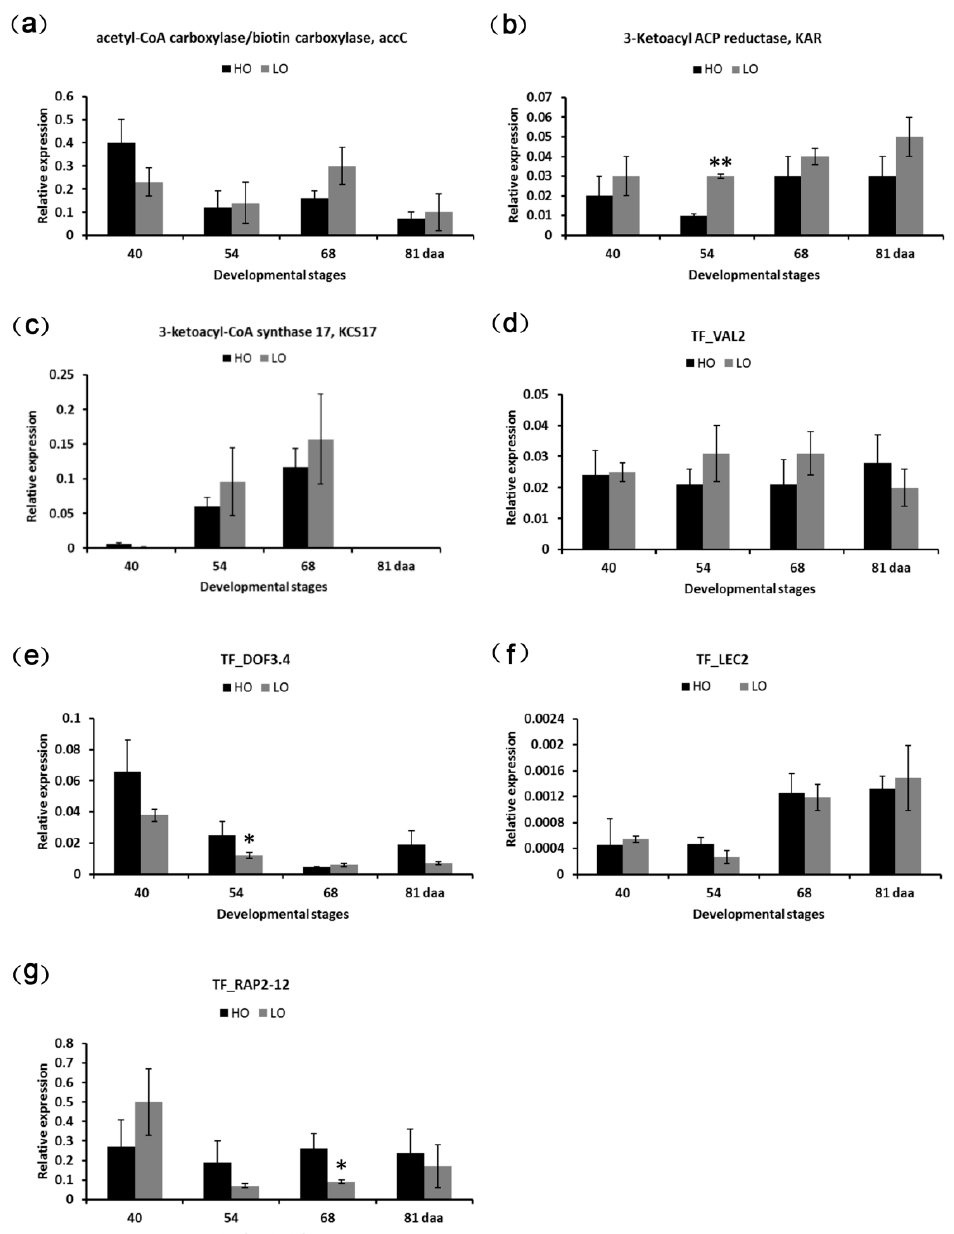
Figure 6. qPCR expressional profiles of 7 DEGs identified via RNA-seq. The X -axis represents sampling time points corresponding to the four embryonic development stages (40, 54, 68, and 81 daa). The Y -axis represents the relative level of expression. Genes are ( a ) accC (Acetyl-CoA carboxylase/biotin carboxylase); ( b ) KAR (3-Ketoacyl ACP reductase); ( c ) KCS17 (3-ketoacyl-CoA synthase 17); ( d ) TF_ VAL2 ; ( e ) TF_ DOF3.4 ; ( f ) TF_ LEC2 ; and ( g ) TF_ RAP2-12 . ** and * indicate significant differences in HO relative to LO at the same development stage by t -test at p < 0.01 and p < 0.05. Error bars represent the SD for three biological replicates.